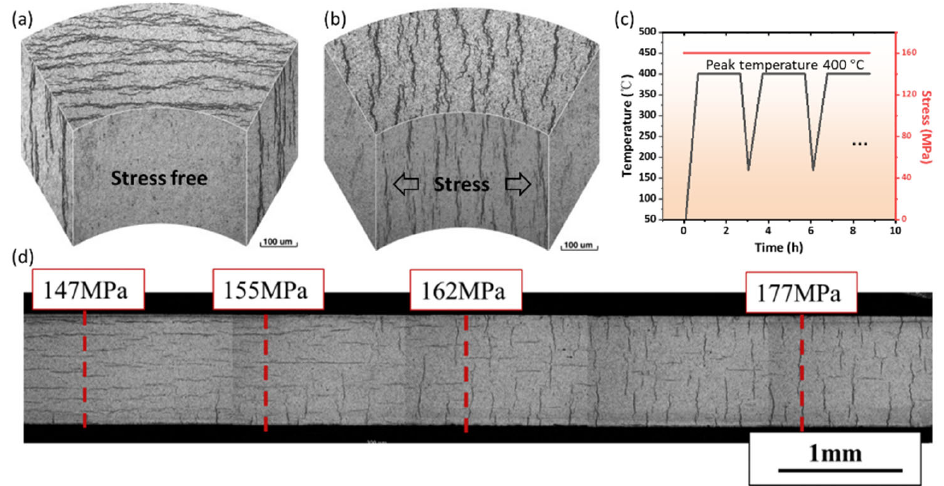
Figure 7. ( a ) Circumferential hydride; ( b ) radial hydride formed after 8 cycles of treatment at 400 °C (peak temperature) and under 160 MPa of tensile stress; ( c ) heat-treatment schedule of the sample [91]; ( d ) distribution of hydride in the cross-section of a tapered uniaxial tension sample after 2 cycles of heat treatment [93]. Reprinted with permission from [91]; Copyright 2008 Elsevier. Reprinted with permission from [93]; Copyright 2016 Elsevier.